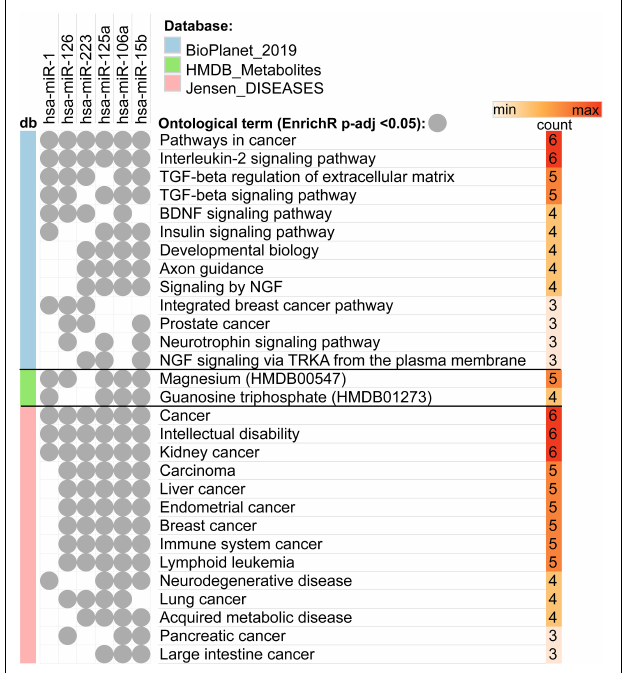
FIGURE 2 | Overlap between enriched ontological terms (pathways, metabolites, and diseases) associated with genes targeted by miRNAs selected for qRT-PCR validation.